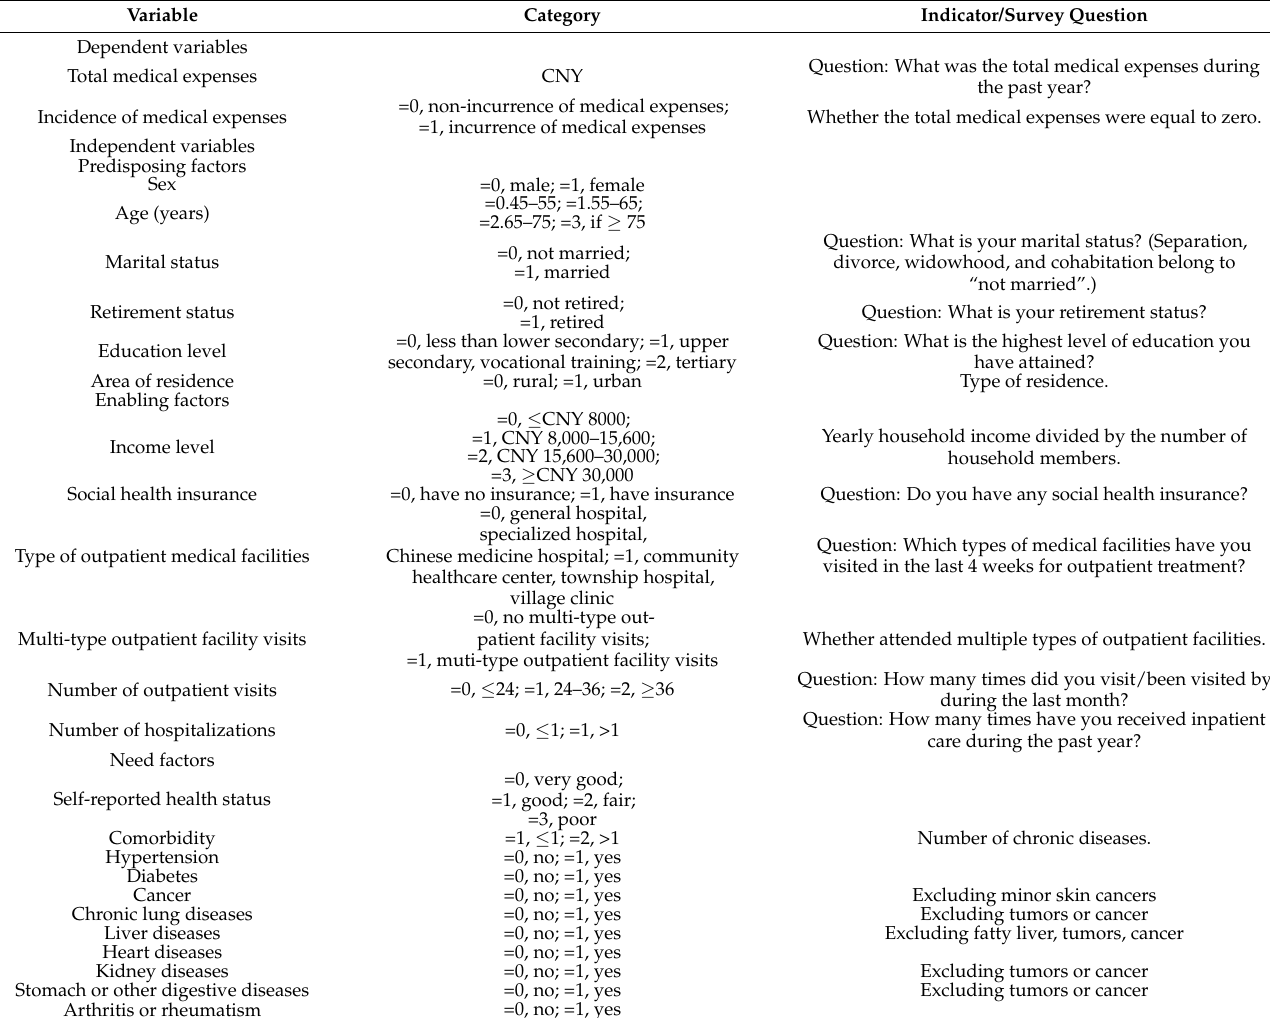
Table 1. Description of the dependent and independent